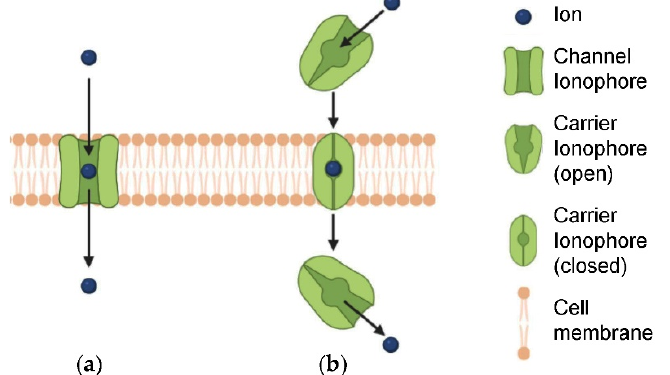
Figure 1. ( a ) Ion channels and ( b ) ion transporters. Reproduced with permission from [26]. Copyright Elsevier 2022.